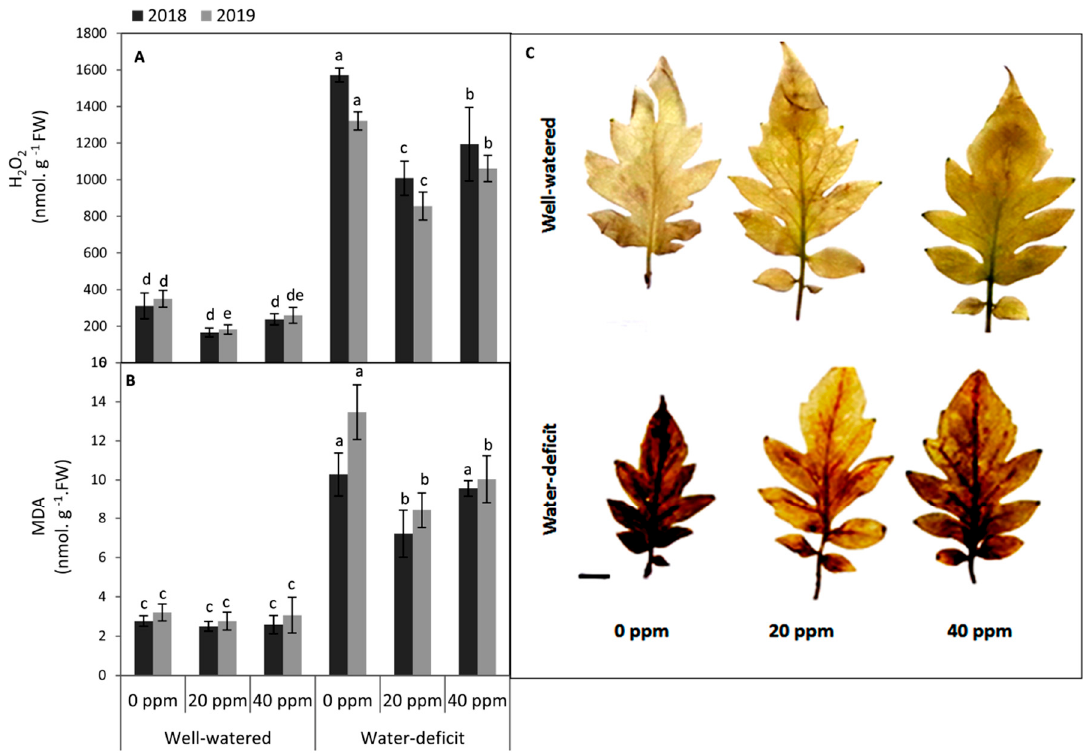
Figure 3. Effect of foliar application of melatonin (MT) at 0, 20 and 40 ppm on ( A ) the concentration of H 2 O 2 , ( B ) lipid peroxidation as indicated by malondialdehyde (MDA) and ( C ) H 2 O 2 distribution using DAB staining in the terminal leaflet of the 4th leaf of tomato plants grown under two different irrigation regimes (Brown DAB staining color indicates accumulation of H 2 O 2 . Bar = 1 cm). Means of three replicates were presented ±SD. Different letters are significant differences, according to Duncan’s multiple range tests ( p < 0.05).